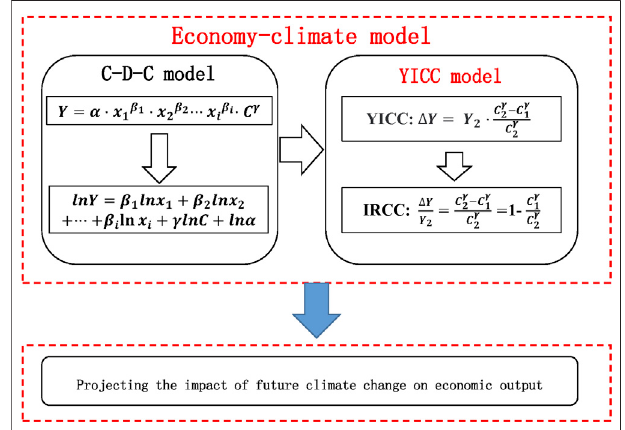
FIGURE 3 | A framework diagram of the economy-climate model for predicting theyield impact ofclimate change. Y is an economic output, x i is an economic factor ( i ≥ 3), β i is an output elasticity corresponding to the economic factor, C is a climatic factor, c is an output elasticity corresponding to climatic factor (called “ climatic output elasticity ” ), α represents the sum of the in fl uence of factors other than economic and climatic factors. Δ Y / Y 2 is the impact ratio of climate change